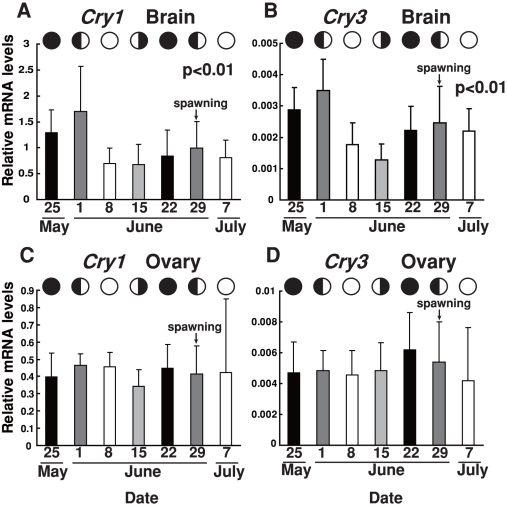
Lunar phase-dependency of SgCry mRNA expression in the brain and ovary.Each Cry mRNA was calculated as a value relative to that of the Sgβ-actin gene. For each lunar phase, mRNA levels at ZT0, ZT6, ZT12 and ZT18 are averaged except for SgCry1 mRNA levels in the brain (mesencephalon and diencephalon). Since SgCry1 showed diurnal variation in the brain, values were normalized to reduce the deviation due to the daily rhythmic changes as follows; values at each daily time point (ZT0, ZT6, ZT12, and ZT18) were divided by the mean values of all the data for the same time point (0.0340, 0.0242, 0.0109, and 0.0141 for ZT0, ZT6, ZT12, and ZT18, respectively). Error bars represent ± SD. Lunar phases are indicated by schematic moon images. (A) Lunar changes in the SgCry1 mRNA levels in the brain. p<0.01, One-way ANOVA. Post hoc test; p<0.05, 5/25 vs 6/8, 6/15; p<0.01, 6/1 vs 6/8, 6/15, 6/22, 6/29, 7/7). (B) Lunar changes in the SgCry3 mRNA levels in the brain. p<0.01, One-way ANOVA. Post hoc test; p<0.05, 6/15 vs 6/22, 7/7; p<0.01, 5/25 vs 6/8, 6/15; p<0.01, 6/1 vs 6/8, 6/15, 6/22, 6/29, 7/7; p<0.01, 6/15 vs 6/29. (C, D) SgCry mRNA levels in the ovary plotted against lunar phase.